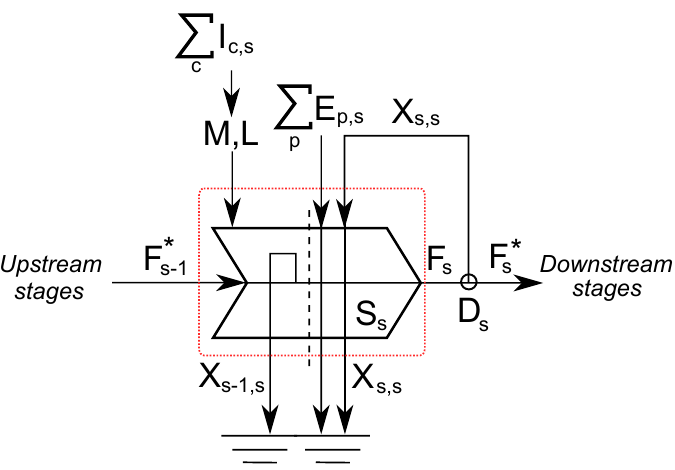
Figure 1. Schematic for flows within a single processing